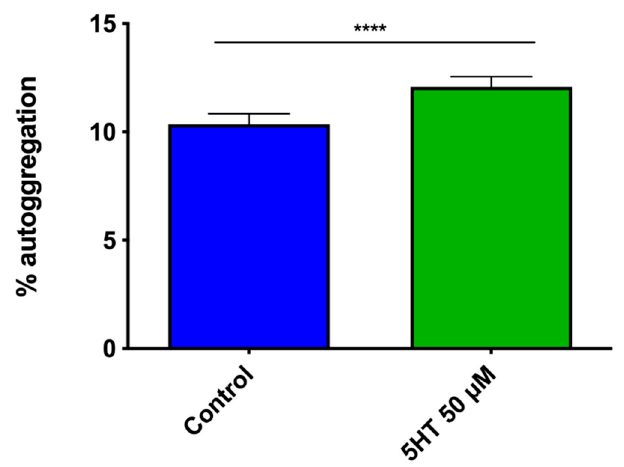
Figure 3. Auto-aggregation . Percent auto-aggregation of E. faecium NCIMB10415 is enhanced after the treatment with 50 µM 5HT (**** p < 0.0001) compared to the control condition .